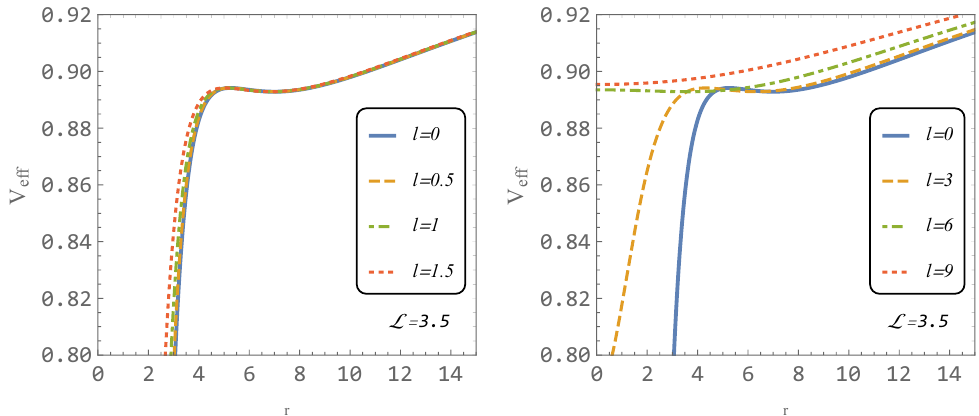
Figure 1. Effective potentials of test particles for characteristic values of the length parameter l and M = 1. Values of l < 2 M giving regular black holes are on the left panel, while values of l > 2 M giving wormholes (except the Schwarzschild case l = 0) are on the right panel.